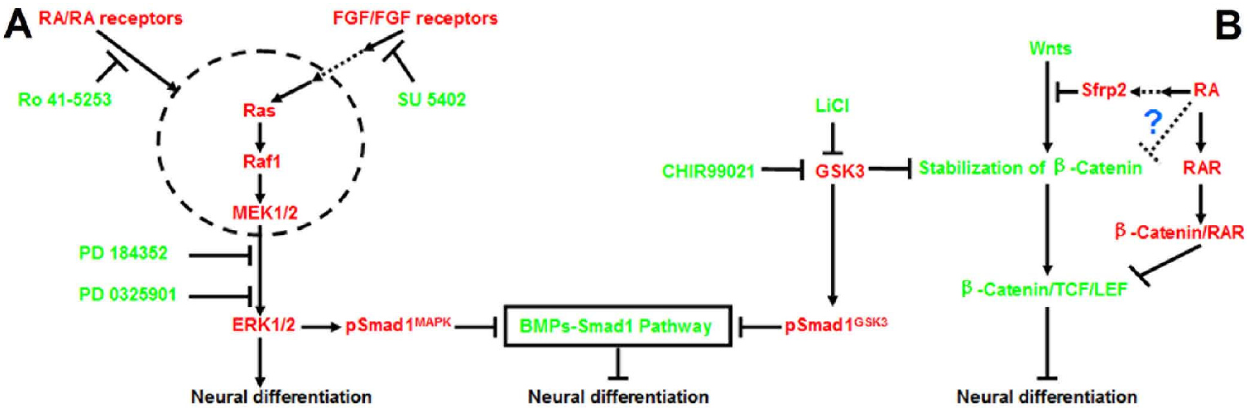
Figure 6 A. Interaction between RA and the ERK pathway during promoted neural specification . FGF receptor tyrosine kinase inhibitor SU5402 and MEK1/2 inhibitors PD184352 and PD0325901, respectively suppresses neural differentiation of ESCs. In RA-treated cultures, PD184352, PD0325901 and RAR α -selective antagonist Ro 415253 could inhibit the neural speci- fication of ESCs, while SU5402 shows weak neural inhibition effect. RA probably enhances ERK phosphorylation via MEK1/2 or its upstream but not in a manner that is dependent on FGF signaling, and activated ERK1/2 mediates phosphorylation of the MAPK sites of Smad1 (pSmad1 MAPK ), which inhibits the inhibitory function of the bone morphogenetic proteins (BMPs)-Smad1 pathway on neural differentiation. Blockade of RA signaling might affect the activation of the upstream of ERK1/2, which leads to failure of neural specification of ESCs even with the stimulation of FGF signaling. B. Possible roles of Wnt signaling in RA-promoted neural differentiation . RA promotes neural specification probably by up-regulating Sfrp2, which inhibits the Wnt- β -catenin anti-neural pathway. Upon adding LiCl or CHIR99021, which stimulates the β -catenin signaling and/or BMP sig- naling through inhibition of GSK3, the suppression effects on neural specification of β -catenin pathway can be passed down even with the stimuli of RA. RA also may promote neural differentiation by up-regulating RAR, which may decrease β -catenin/ LEF/TCF mediated transactivation. There exists a possibility that RA may suppress the inhibition effects on neural differentia- tion of Wnt- β -catenin pathway by sequestration of β -catenin. pSmad1 GSK3 indicates phosphorylation of the GSK3 sites